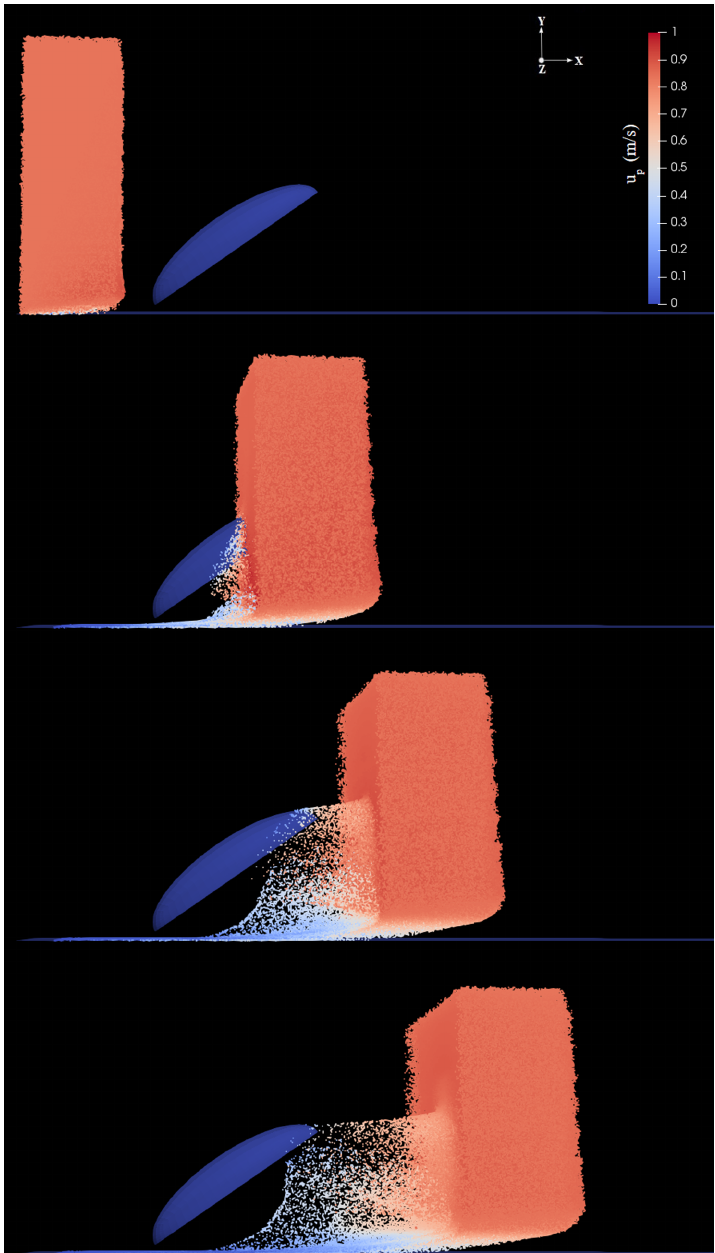
Figure 5. Temporal evolution of the slab of droplets injected horizontally (parallel to the ground) into the computational domain for α = 40 deg (run A6). Droplets are colored with the magnitude of droplet velocity ( u p in Equation (3)). From top to bottom, panels correspond to t = 3.5ms, 12.5ms, 17ms, and 20ms after droplets injection. An animation of this sequence is available in the Supplementary Materials